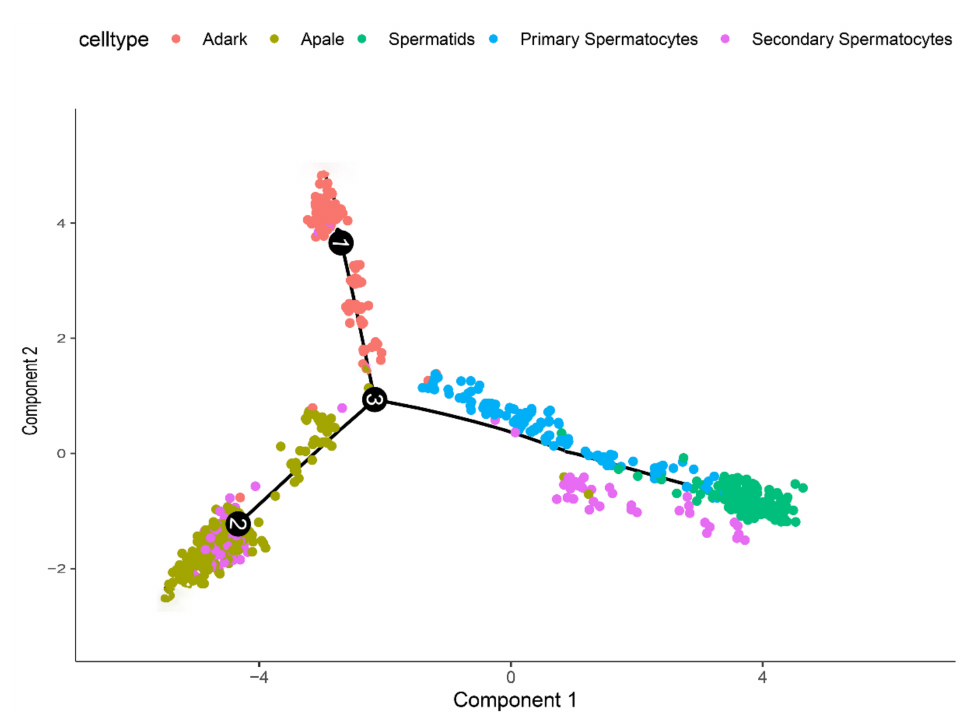
Figure 5. Cell trajectory analysis of sheep testicular germ cells. Cell trajectory analysis of five germ cell types. This analysis indicated that these cell subsets had the following developmental order: A pale —primary spermatocytes—secondary spermatocytes—spermatids, while A dark are slow